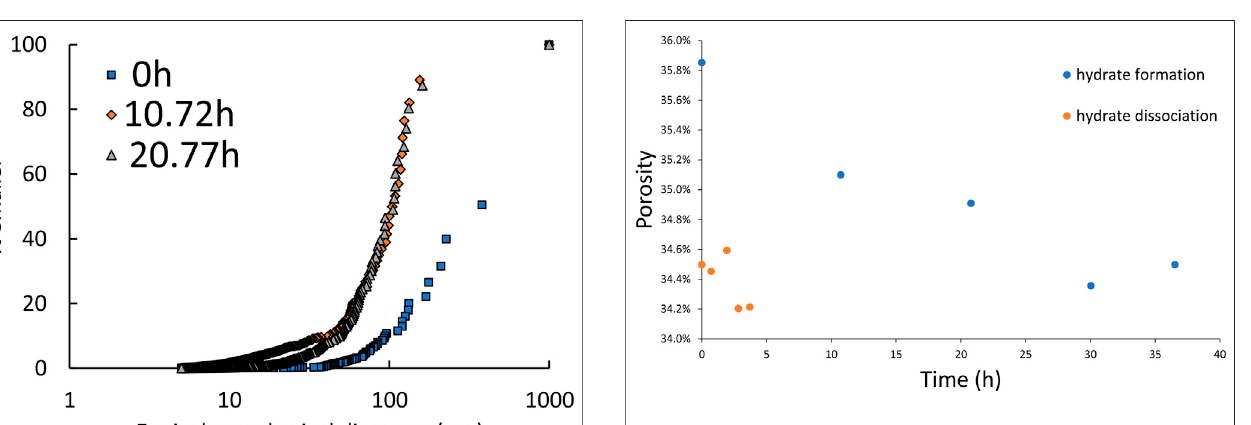
FIGURE 6 | Result of porosity from the analyzed scans during hydrate formationanddissociationstages.Irrecoverabledensi fi cationofthespecimen was observed due to methane gas consumption for hydrate formation.